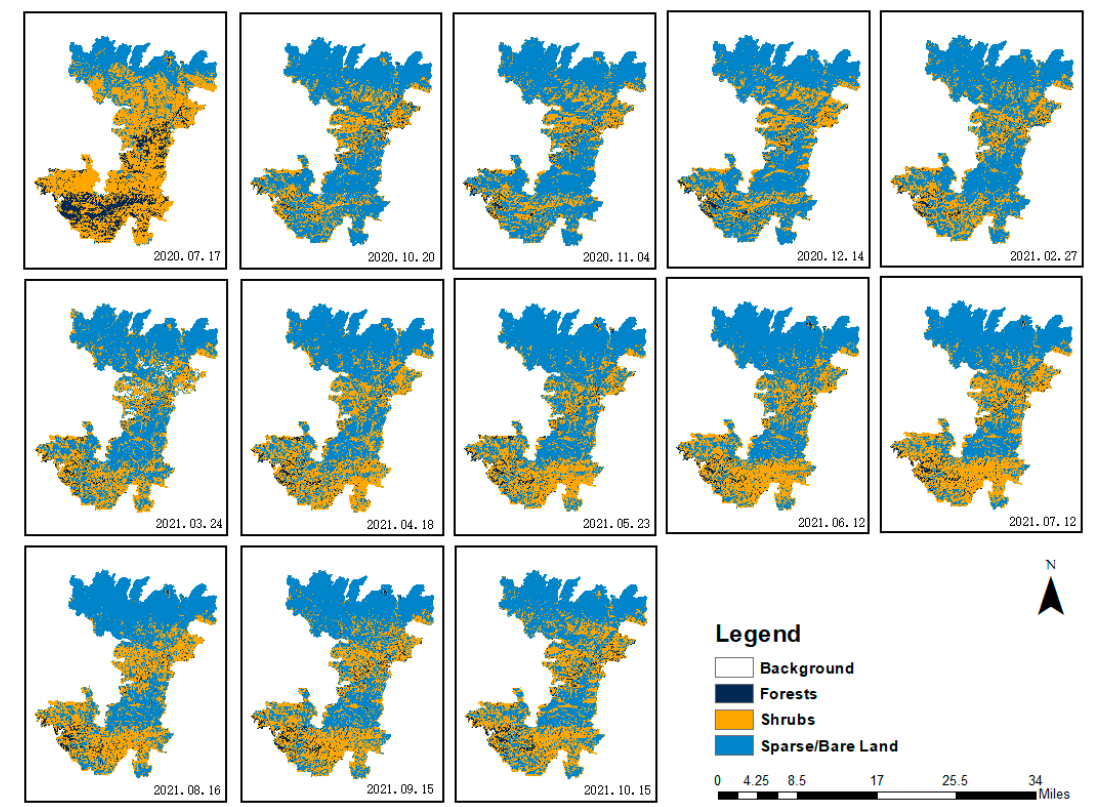
Figure 6. Map of vegetation community time-series change.